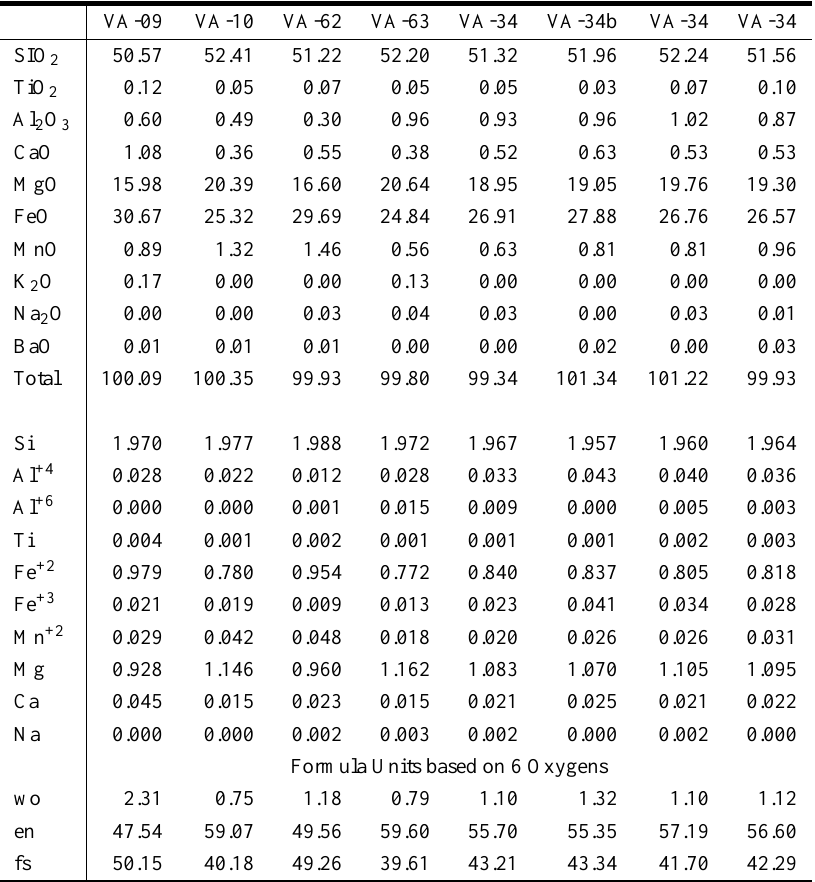
Representative Microprobe analyses of OPX